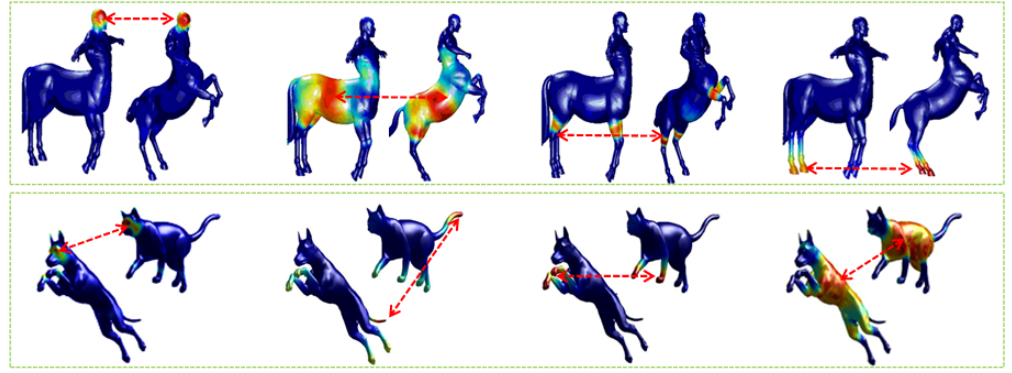
Figure 10. Demonstration of robustness and discrimination of our framework. The upper and lower rows show the joint hidden variables of two centaur models (under isometric deformation) and two different animal models,